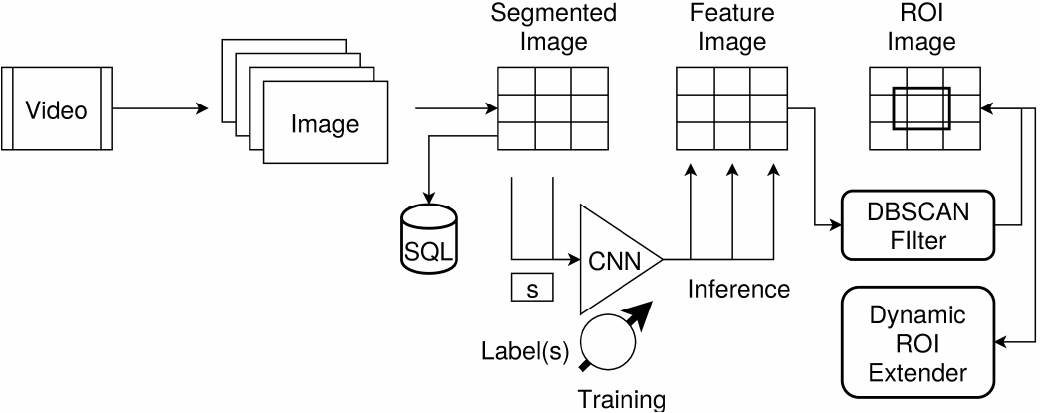
Figure 2. Overview of the data flow architecture and the used algorithms.